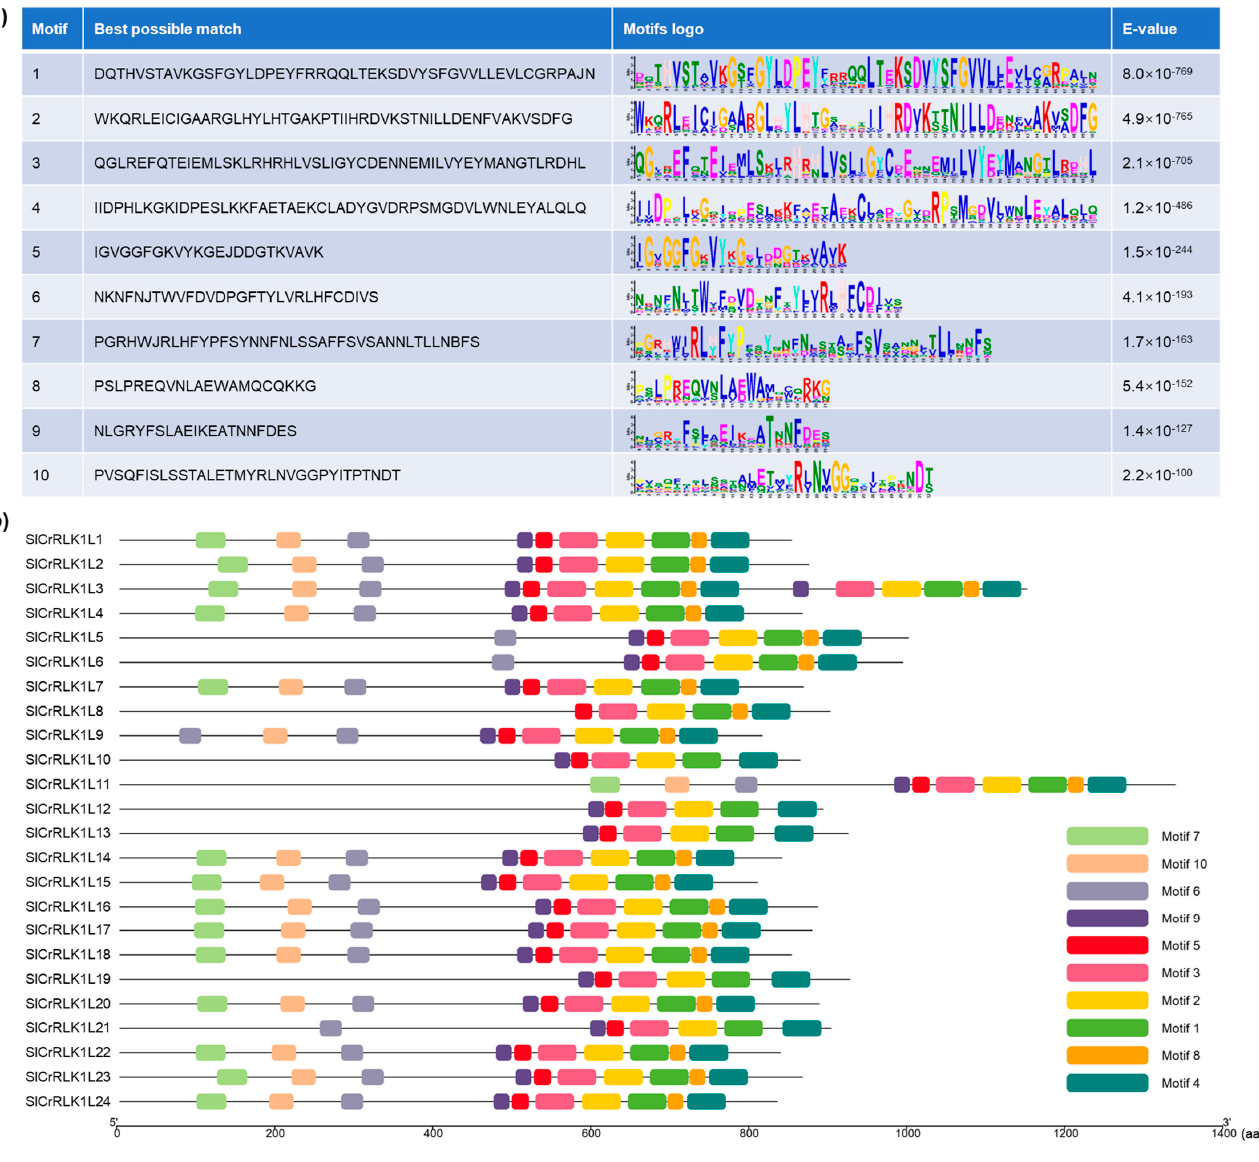
Figure 5. Predicted conserved motifs of SlCrRLK1Ls. ( a ) The best possible match sequences and motif logos are listed here. ( b ) Motif positions on the SlCrRLK1Ls. motif logos are listed here. ( b ) Motif positions on the